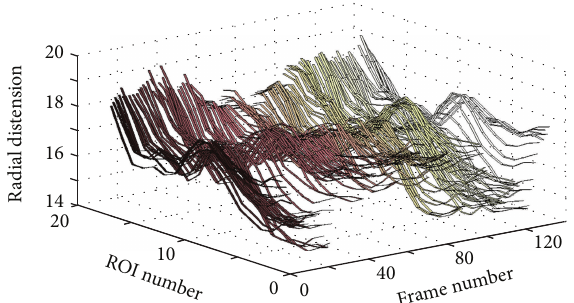
Figure 8: 3D plot showing the wave propagation along the vessel wall for the pathological case CAD1 (coronary case 1).